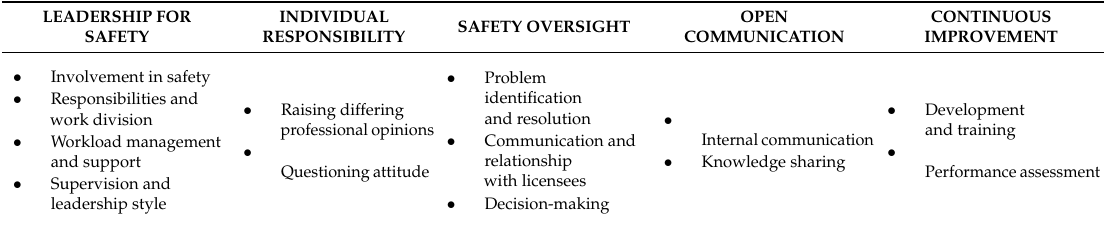
Table 1. Dimensions and subdimensions to be assessed.